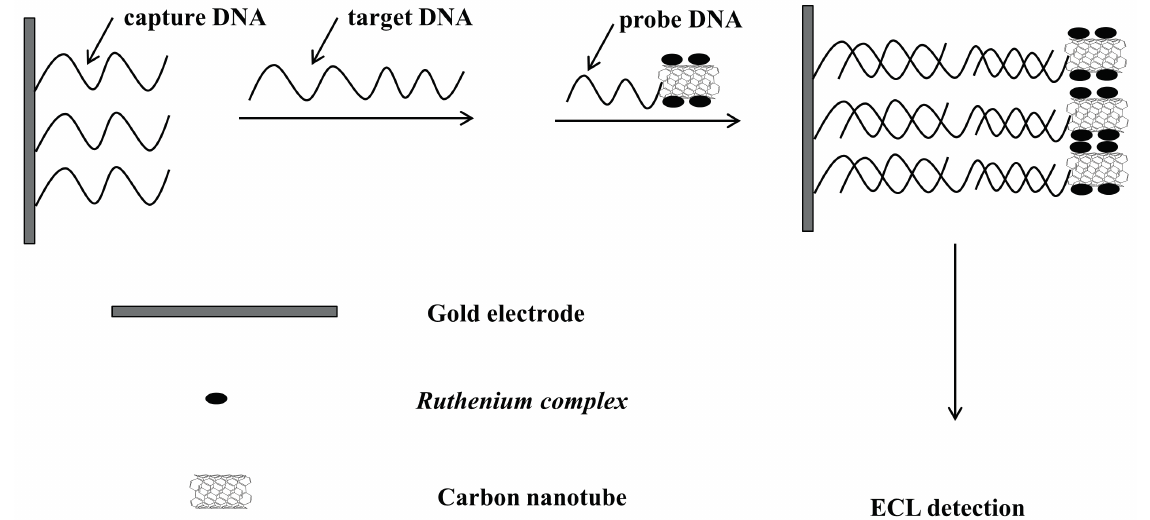
Figure 9. Sandwich sensing platform for ECL DNA detection using probe ssDNA and ruthenium complexes loaded carbon-nanotubes as ECL probes. Reprinted with permission from ref. [176], copyright (2007) Elsevier.